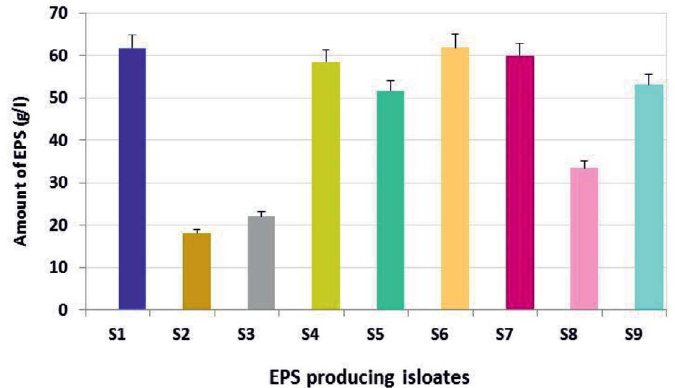
Fig. 2. Yield of EPS produced fromthe most promising isolates.To determine the EPS yield produced fromthe selected strains, fresh pre-cultures were inoculated in 250 mlErlenmeyer flasks containing 50 ml of the sterile fermentation medium(pH 7.0) supplemented individually with different concentrations of sucrose or lactose, glucose and fructose. All flasks were incubated at 30°C for 3 days on a rotary shaker. The cultures were centrifuged and the EPS was extracted, purified, lyophilized, and then the weight of the dried EPS was gravimetrically measured according to Kumar et al. 27 , Huang 28